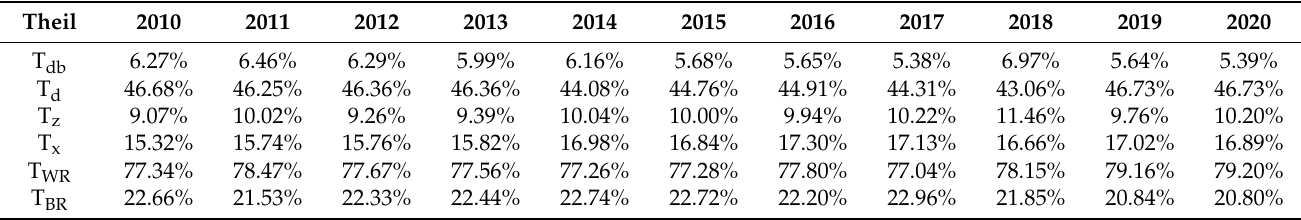
Figure 1. Decomposition of regional differences in urban “production, living and ecological” envi- ronmental quality scores for the period 2010–2020. Table 3. Contribution of within-group and between-group variation in Theil’s